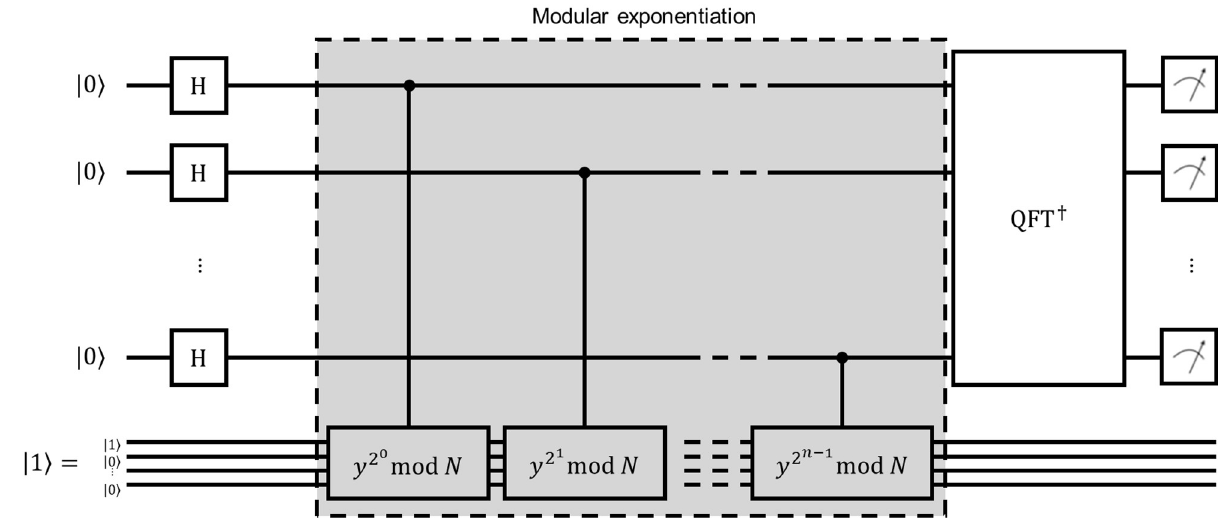
Fig 2. Quantum circuit implementing the order-finding